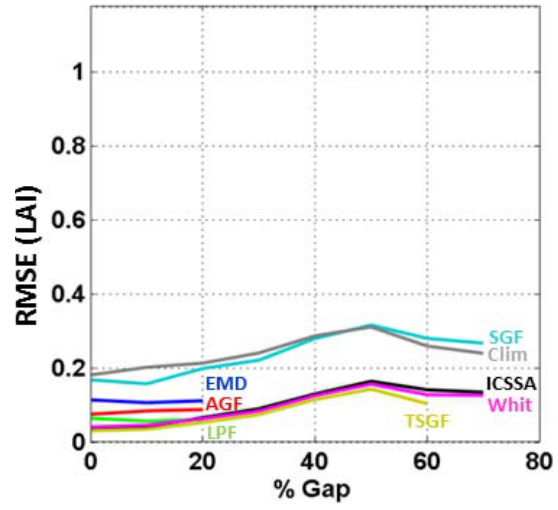
Fig. 7. RMSE as a function of %gap. The RMSE is computed be- tween LAI ref and the reconstructed LAI rec time series over dates with actual observations in LAI sim . The values were slightly shifted vertically to ease the reading when curves were